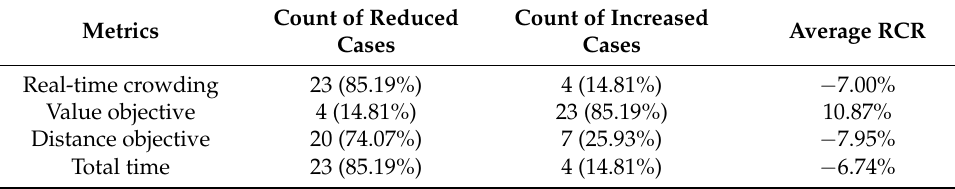
Table 6. The RCR of four metrics after the